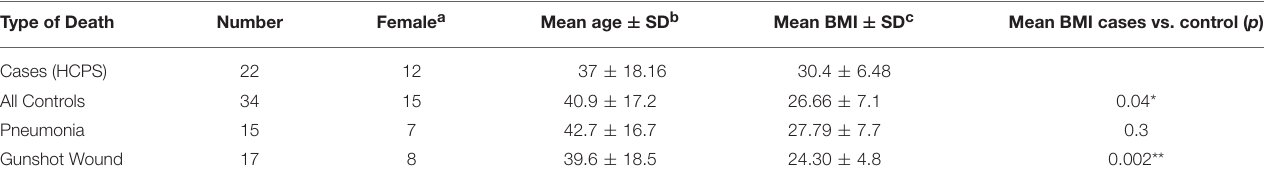
TABLE 2 | Summary of P2Y 2 R study HCPS decedent